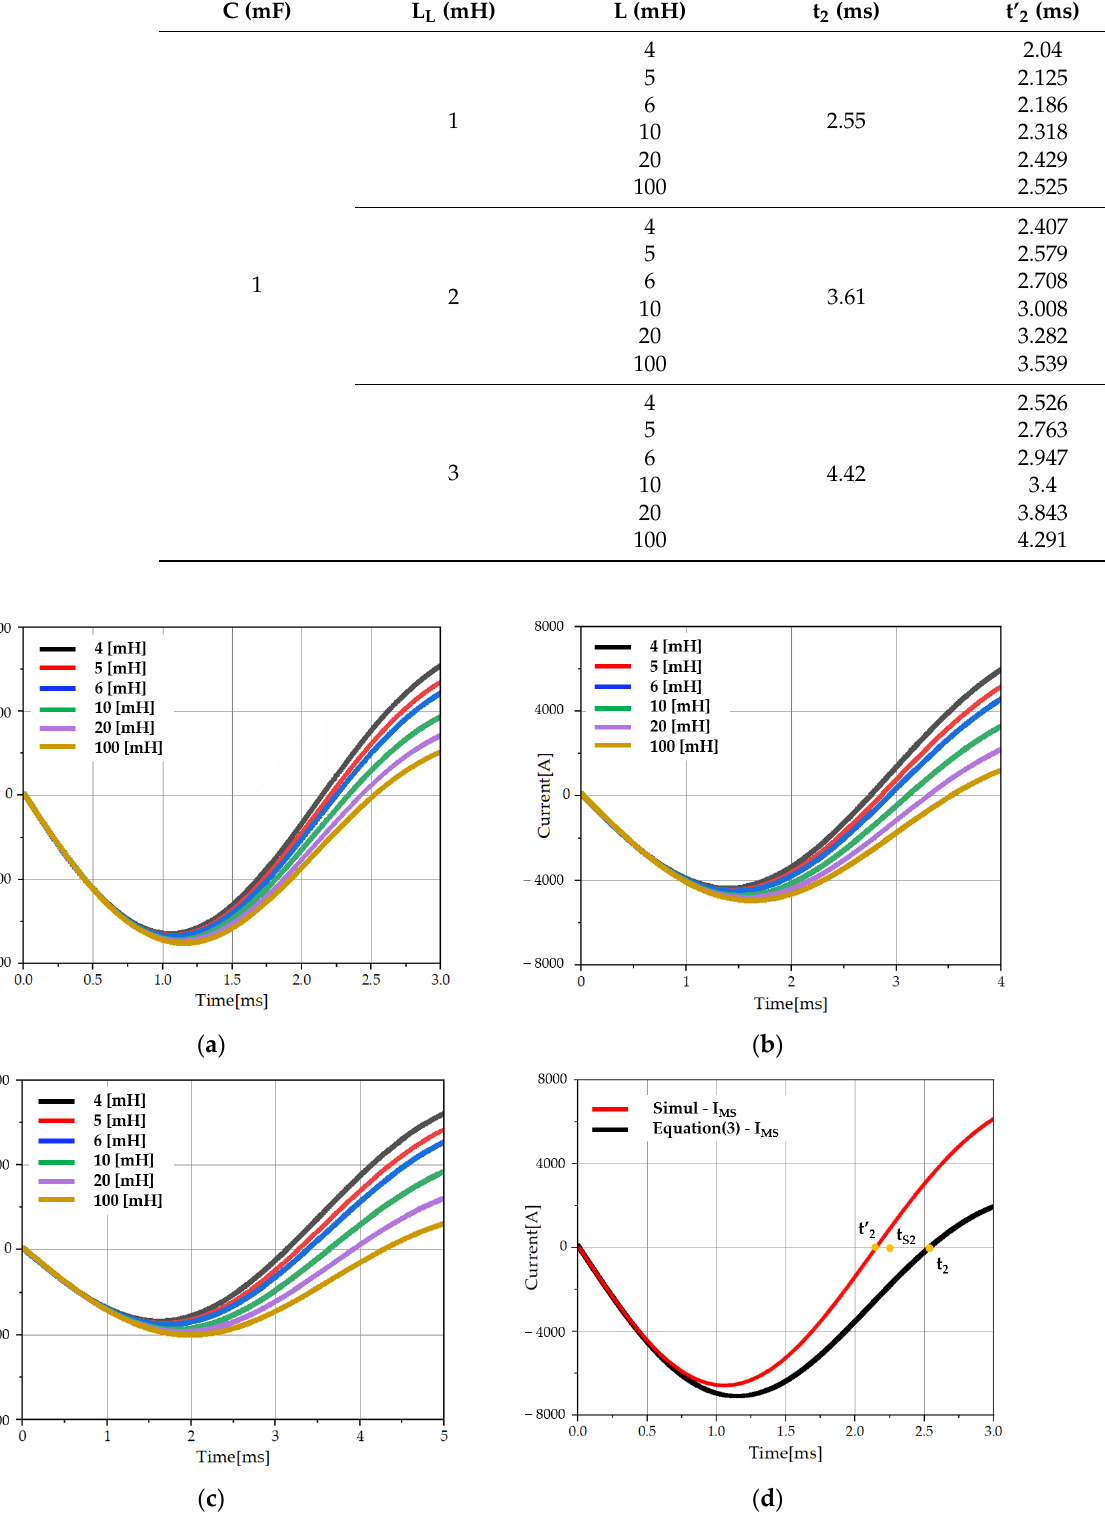
Figure 7. Simulation of current changes due to system inductance and network inductance simula-